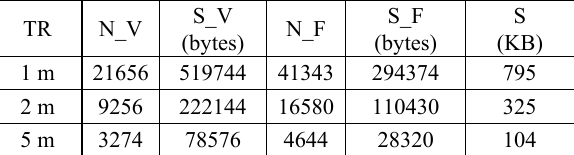
Table 2. Characteristics of the three sampled TIN. N_V: